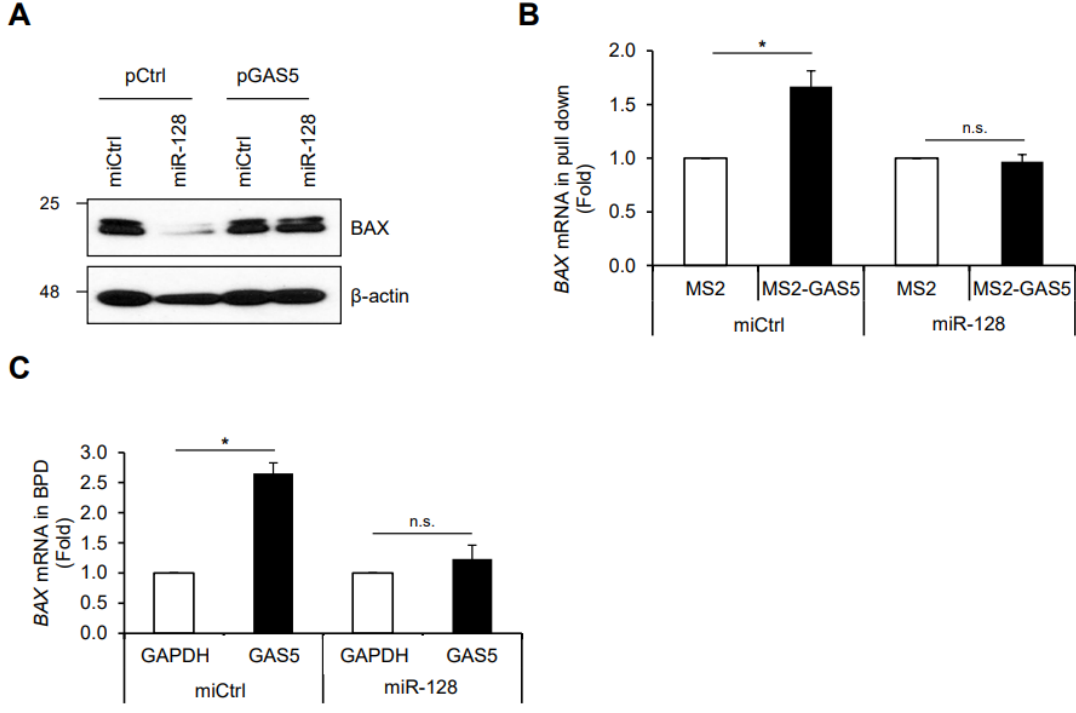
Figure 5. Competitive regulation of BAX expression by GAS5 and miR-128-3p. ( A ) After the co- transfection of plasmids and miRNAs into HCT116 cells, relative BAX expression was assessed by western blotting analysis. β -actin was used as a loading control. ( B ) Hep3B/F-MS2BP cells were co-transfected with plasmids and miRNAs; the MS2-GAS5-containing ribonucleoprotein complex was isolated using Flag-Ab beads. The enrichment of BAX mRNA in the complex was analyzed by RT-qPCR. ( C ) After transfection of HCT116 cells with miRNAs, cell lysates were incubated with biotin-labeled transcripts, and the GAS5-containing RNA complex was isolated using a Streptavidin bead. The association between GAS5 and BAX mRNA in the complex was analyzed by RT-qPCR. GAPDH mRNA was used for the normalization. Data were expressed as mean ± SEM, and images are representative of three independent experiments. The statistical significance of the data was analyzed via Student’s t -test; *, p < 0.05, n.s., not significant.